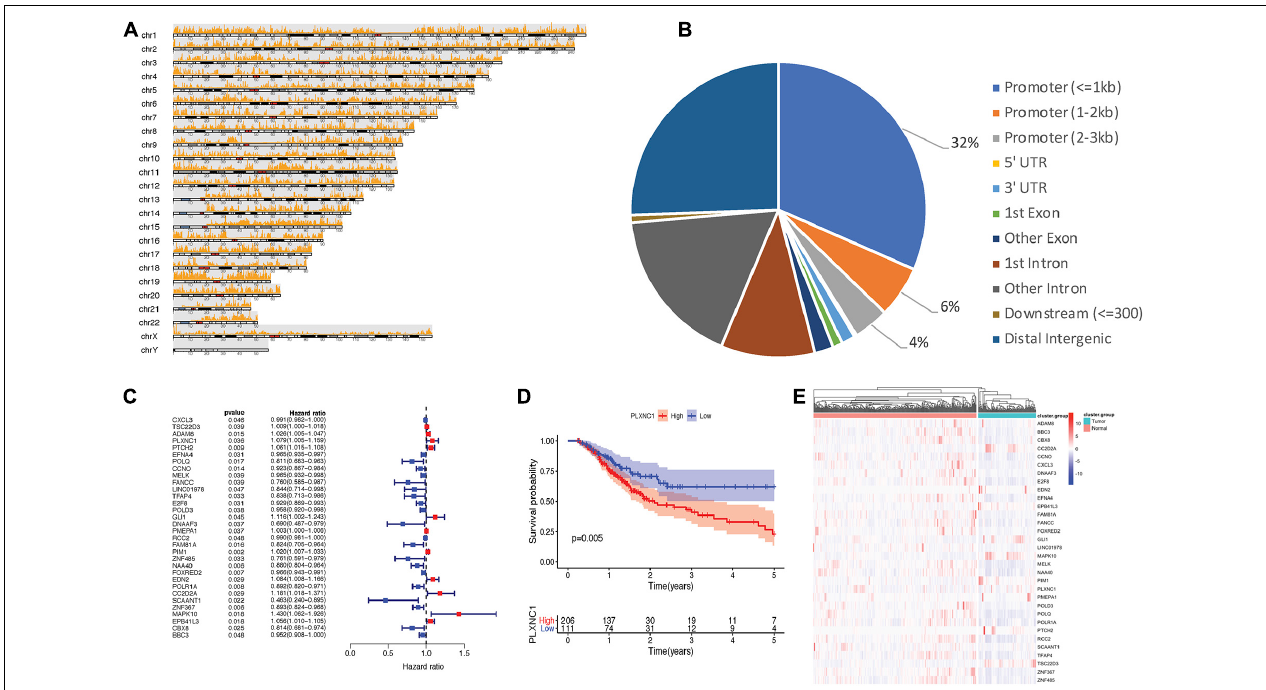
FIGURE 2 | (A) Visualization of open regions across the whole genome. (B) Pie chart of genomic features indicating that most open chromatin regions were located in promoter regions. (C) Forest plot of univariate Cox models. A total of 32 genes were identified as survival-related DEGs, among which 11 DEGs had a hazard ratio